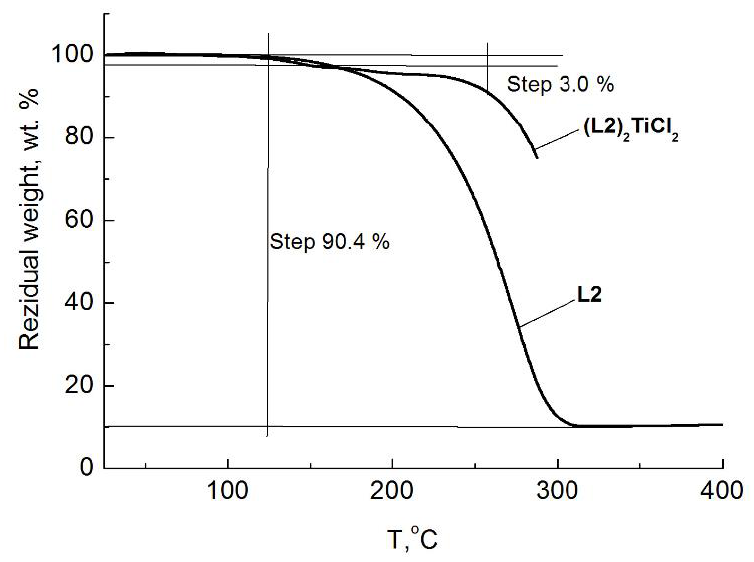
Figure 1. Thermogravimetry curve of ligand L2 and complex (L2) 2 TiCl 2 . For the complexes (L1) 2 Ti(OiPr) 2 (A) , (L1) 2 Zr(OiPr) 2 (B) , (L2) 2 Zr(OiPr) 2 (C) , and (L1) 2 Zr(Cl) 2 (D) , we managed to grow single crystals suitable for X-ray diffraction studies; the results are shown in Figure 2. According to X-ray diffraction data, all isopropoxide complexes (L1) 2 Ti(OiPr) 2 , (L1) 2 Zr(OiPr) 2 , and (L2) 2 Zr(OiPr) 2 have similar structure and contain two ligand molecules and two isopropoxide groups. Metal atoms in these com- plexes have a distorted octahedral environment by the four O atoms and two N atoms of ligands. The oxygen atoms of two phenoxy imine ligands are situated in the trans-position and two oxygen atoms of isopropoxide group are in the cis-position. Dichloride complex (L2) 2 ZrCl 2 also has octahedral structure with similar orientation of phenoxy imine ligands. Selected bond and angles are presented in Table S2. B